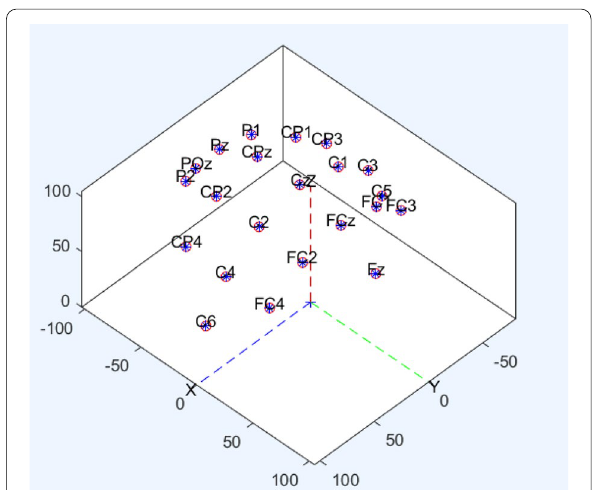
Fig. 4 The distribution of the electrodes in 3D